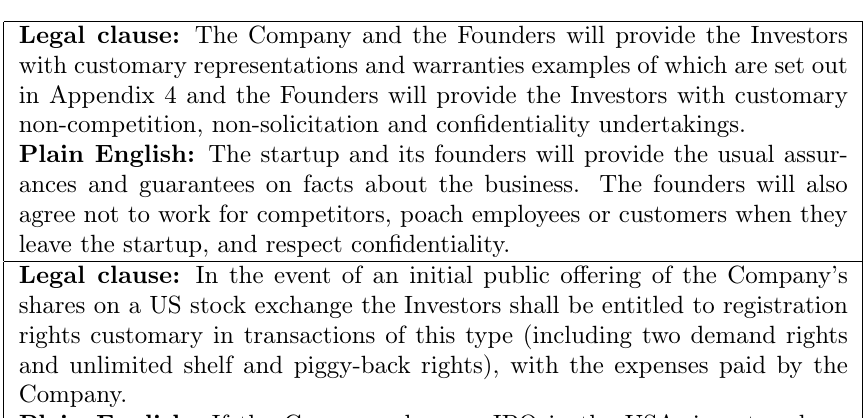
Table 4. The only two examples in the training data for the GPT-3 AI